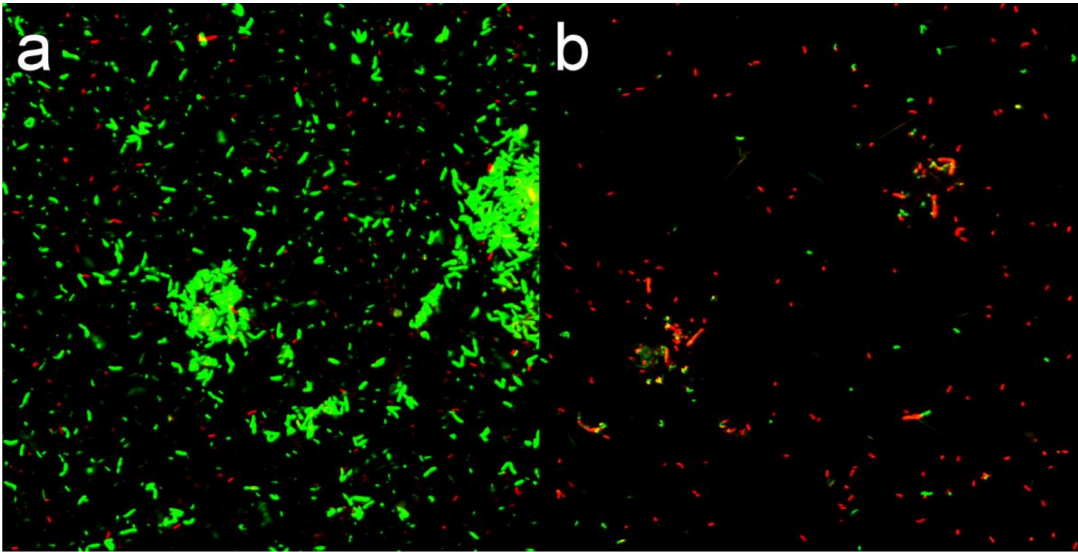
Figure 8. Bacterial fluorescence image treated by SYTO9 / PI. ( a ) Control group; ( b ) treated by CMC-SNs for 12 h.